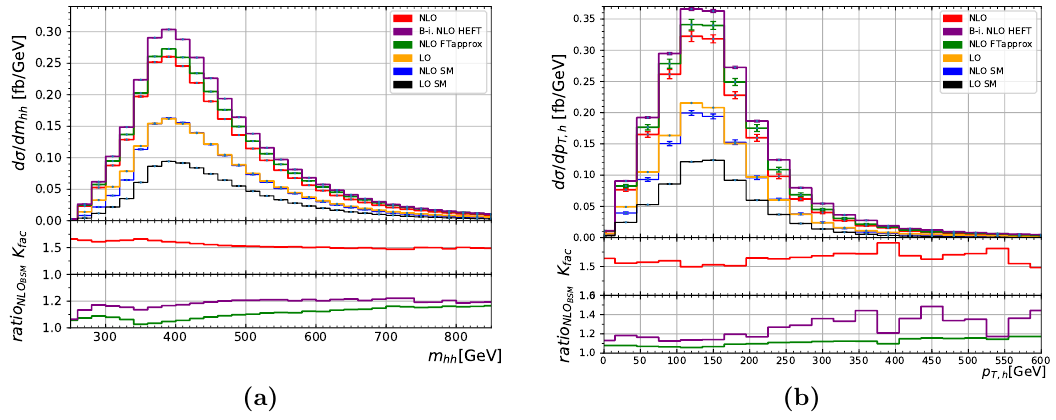
Figure 16. A point from cluster 4, c hhh = 1 ; c t = 1 ; c tt = 0 ; c ggh = 4 = 15 ; c gghh = (cid:0) 0 : 2, which leads to a similar shape as benchmark point 4, but to a much smaller cross section.